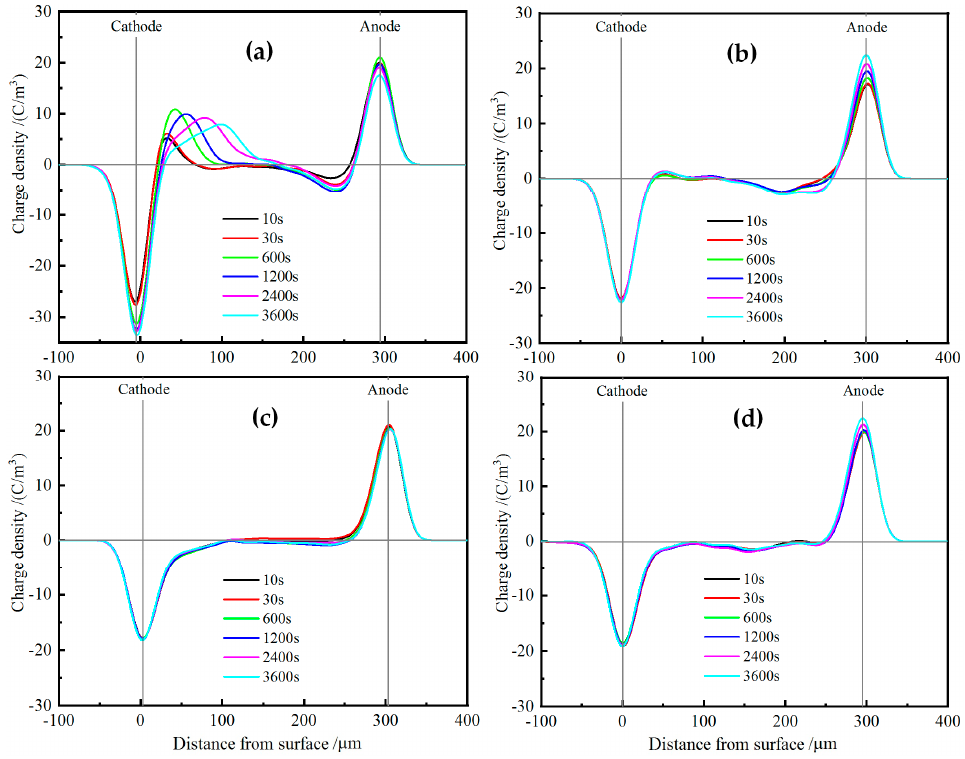
Figure 10. Space charge distributions in ( a ) pure XLPE and the nanocomposites of ( b ) 0.5wt%TAIC- s -SiO 2 /XLPE, ( c ) 1.5wt%TAIC- s -SiO 2 /XLPE and ( d ) 2.0wt%TAIC- s -SiO 2 /XLPE under DC electric field of 40 kV/mm at 60